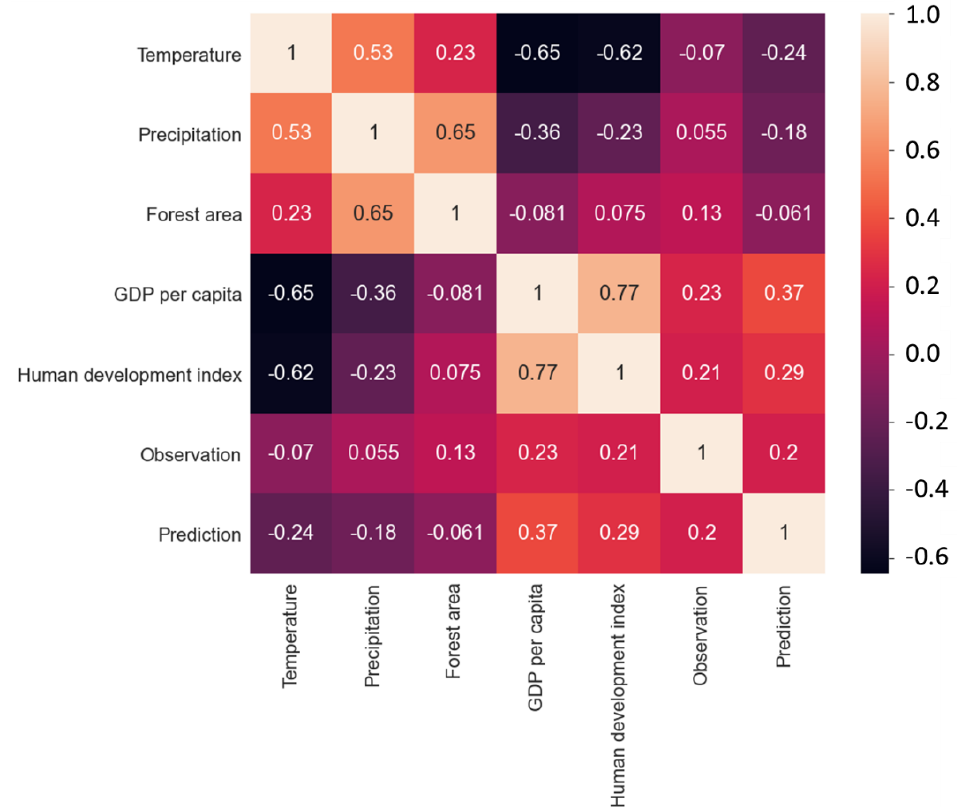
Figure 4. Heatmap analysis showing the relationship between “Temperature”, “Precipitation”, “Forest area”, “GDP per capita”, “Human development index”, “Observation”, and “Prediction”. The brighter the colour, the stronger the positive correlation between the two data.